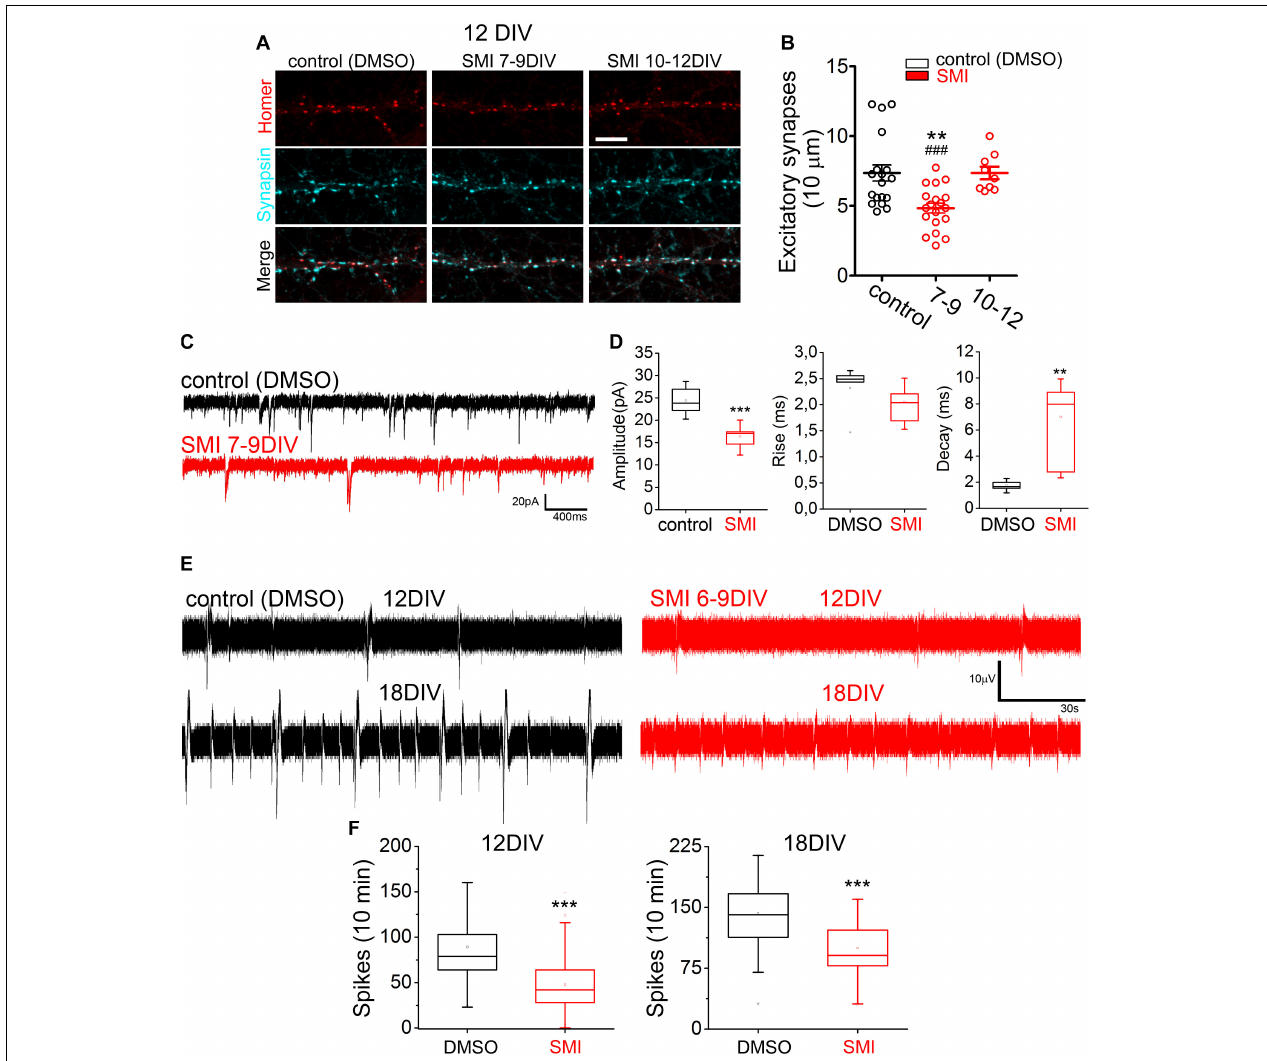
FIGURE 6 | TRAF6 blockage during neuronal development reduces synapse formation affecting neuronal activity. (A , B) Treatment with SMI TRAF6 reduces the number of excitatory synapses. (A) Representative confocal images of dendritic segments stained with antibodies against synaptic markers (red, postsynaptic Homer; cyan, presynaptic Synapsin-1) at 12 DIV. As indicated, rat hippocampal neurons were previously treated with SMI TRAF6 or with the solvent only for 48 h between days 7–9 or 10–12. Scale bar = 10 µ m. (B) Quantification of the number excitatory synapses per 10 µ m of dendritic segment from N = 3 independent cultures (control = 7.36 ± 0.58, n = 19; 7–9 = 4.84 ± 0.35, n = 19; 10–12 = 7.36 ± 0.45, n = 9). ** p < 0.01 vs. control and ### p < 0.001 vs. 10–12 using Student’s t -test. (C,D) Treatment with SMI TRAF6 impairs mEPSCs in hippocampal neurons. (C) Representative traces of intracellular recordings of mEPSCs. (D) Quantification of the amplitude (DMSO = 24.389 ± 1.531; SMI = 16.384 ± 0.829), rise time (DMSO = 2.320 ± 0.2150; SMI = 2.054 ± 0.113), and decay time (DMSO = 1.729 ± 0.190; SMI = 7.008 ± 1.039) of mEPSCs of 12 DMSO-treated and 14 SMI TRAF6-treated neurons from N = 4 independent cultures. *** p < 0.001 or ** p < 0.01 vs. DMSO using Student’s t -test. (E,F) Reduced network activity in SMI TRAF6-treated hippocampal neurons grown on MEAs. (E) Traces of extracellularly recorded neuronal activity obtained consecutively when neurons were 12 and also 18 DIV. (F) Quantification of the number of spikes per electrode were obtained using Matlab (12 DIV: DMSO = 89.2 ± 3.5, SMI = 47.6 ± 1.9; 18 DIV: DMSO = 142.5 ± 2.8, SMI = 79.5 ± 2.2) from N = 3 or 4 independent cultures.